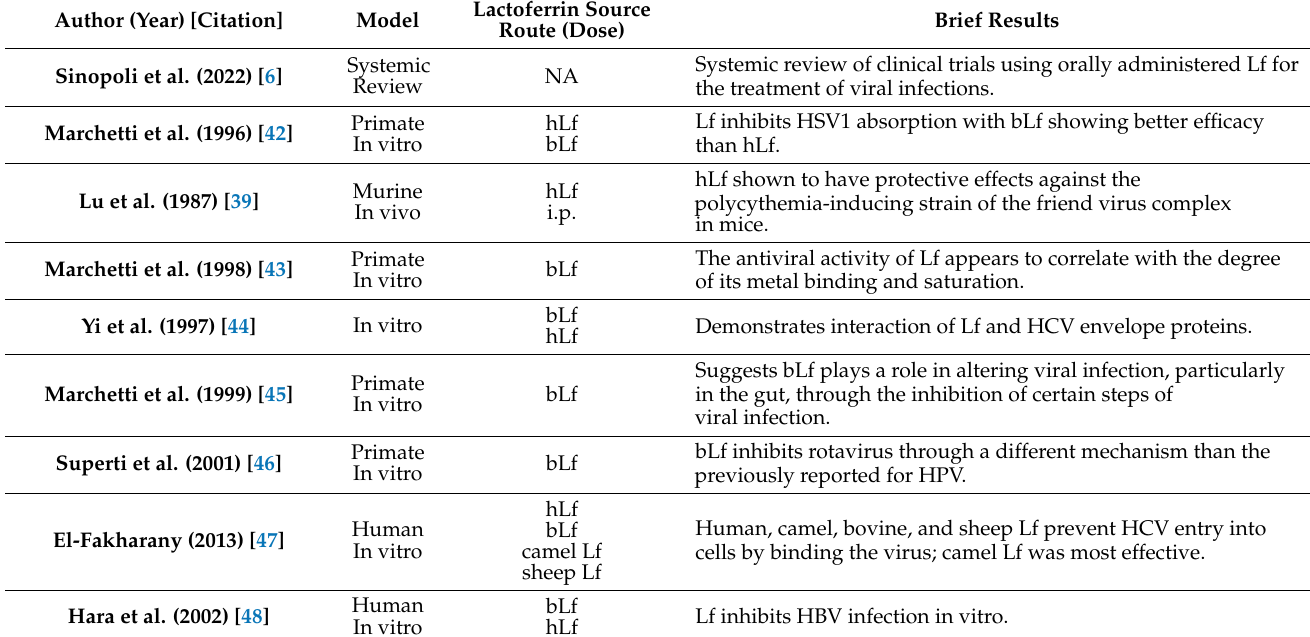
Figure 2. Lactoferrin and viral infection. ( A ) Lactoferrin (Lf) can directly prevent viral entry through preventing viral engagement with host cell target receptors, such as hepatitis B virus (HBV) binding to glycosaminoglycan (GAG), hepatitis c virus (HCV) binding to cluster of differentiation 81 (CD81), and herpes simplex virus type 1 (HSV-1) binding to low-density lipoprotein receptor-related protein 1 (LRP1). ( B ) Lf uptake through the transferrin receptor (TfR) by host cells promotes the expression of antiviral genes and the inhibition of proinflammatory genes. ( C ) The proposed Lf mechanism in SARS-CoV-2 infection includes blocking viral binding to accessory target molecules, such as heparan sulfate proteoglycan (HS-PG) and sialic acid glycoprotein (SIA-PG), ( D ) direct binding to viral particles, and ( E ) the competitive inhibition of viral binding to the angiotensin-converting enzyme (ACE2) receptor. Additional abbreviations include: TGFB = transforming growth factor beta; IRF = interferon regulatory transcription factor; IFN = interferon; TLR = toll-like receptor; ICAM = intracellular adhesion molecule; IL = interleukin; TSLP = thymic stromal lymphopoietin. Table 1. Summary of antiviral studies with lactoferrin. In silico, in vitro, and clinical trials utilizing human, bovine, or other sources of lactoferrin are outlined below with the source of lactoferrin, route of administration (if in vivo), and summary of the relevant results from the main